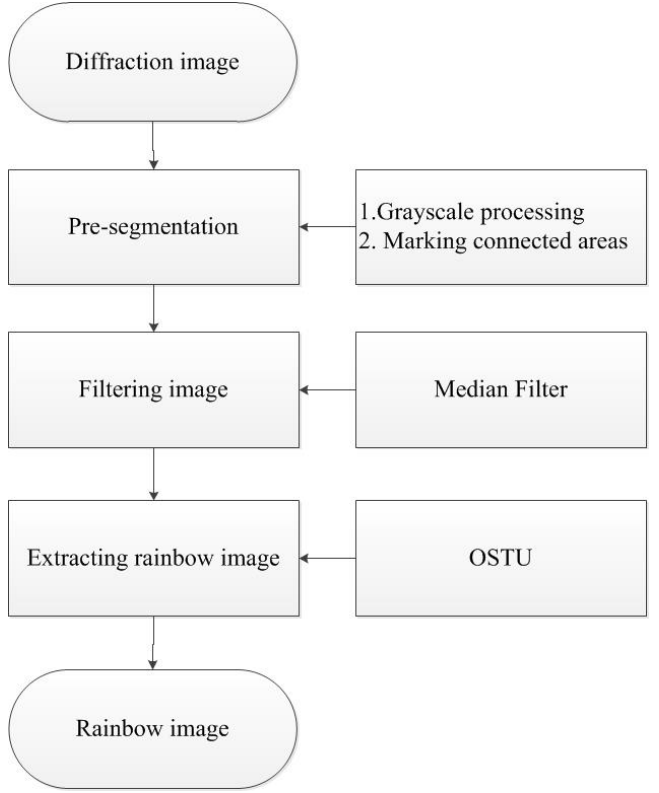
Figure 3. The proposed framework for extracting rainbow image.